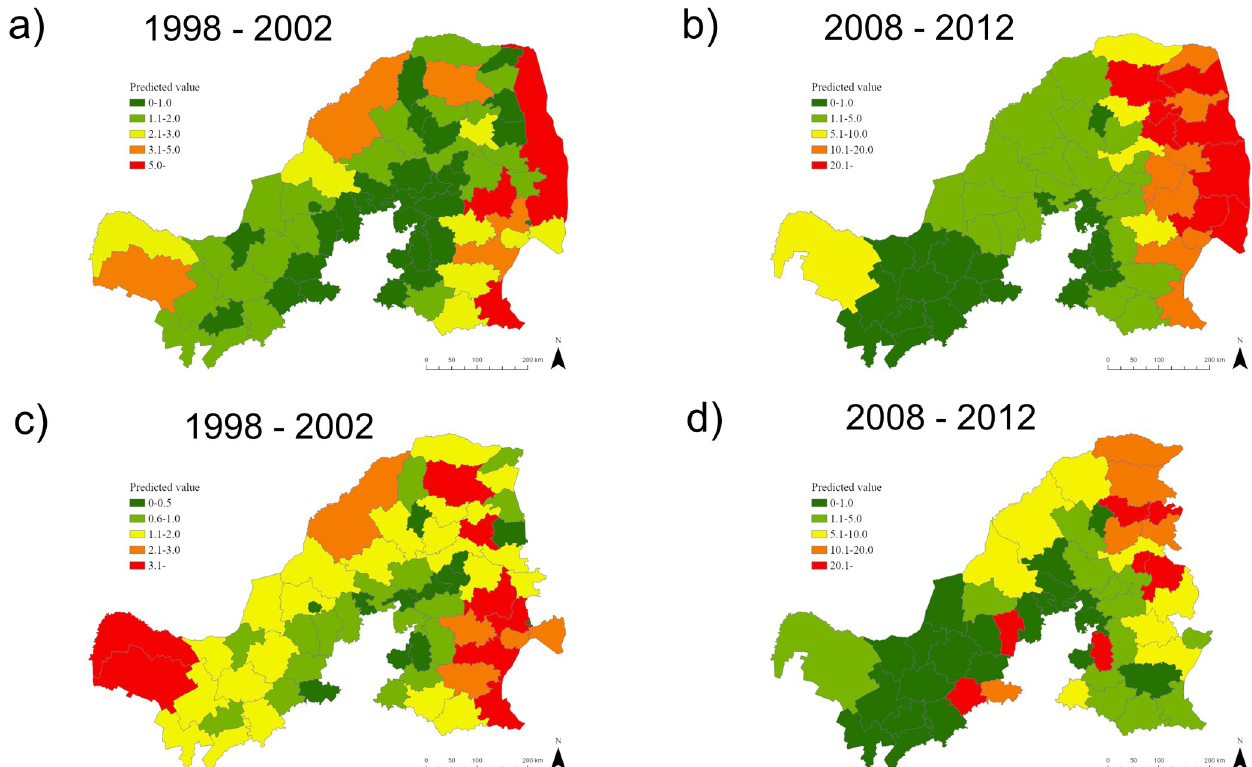
Fig 7. Predicted ecological risk of dog rabies. Panel a) the risk between 1998 and 2002 with the Kruger National Park (KNP); b) between 2008 and 2012 with the KNP; c) between 1998 and 2002 without the KNP; and d) between 2008 and 2012 without the KNP. Red municipalities had the highest rabies risk, whereas green areas had the lowest risk. < https://dataportal-mdb-sa.opendata.arcgis.com/ > .